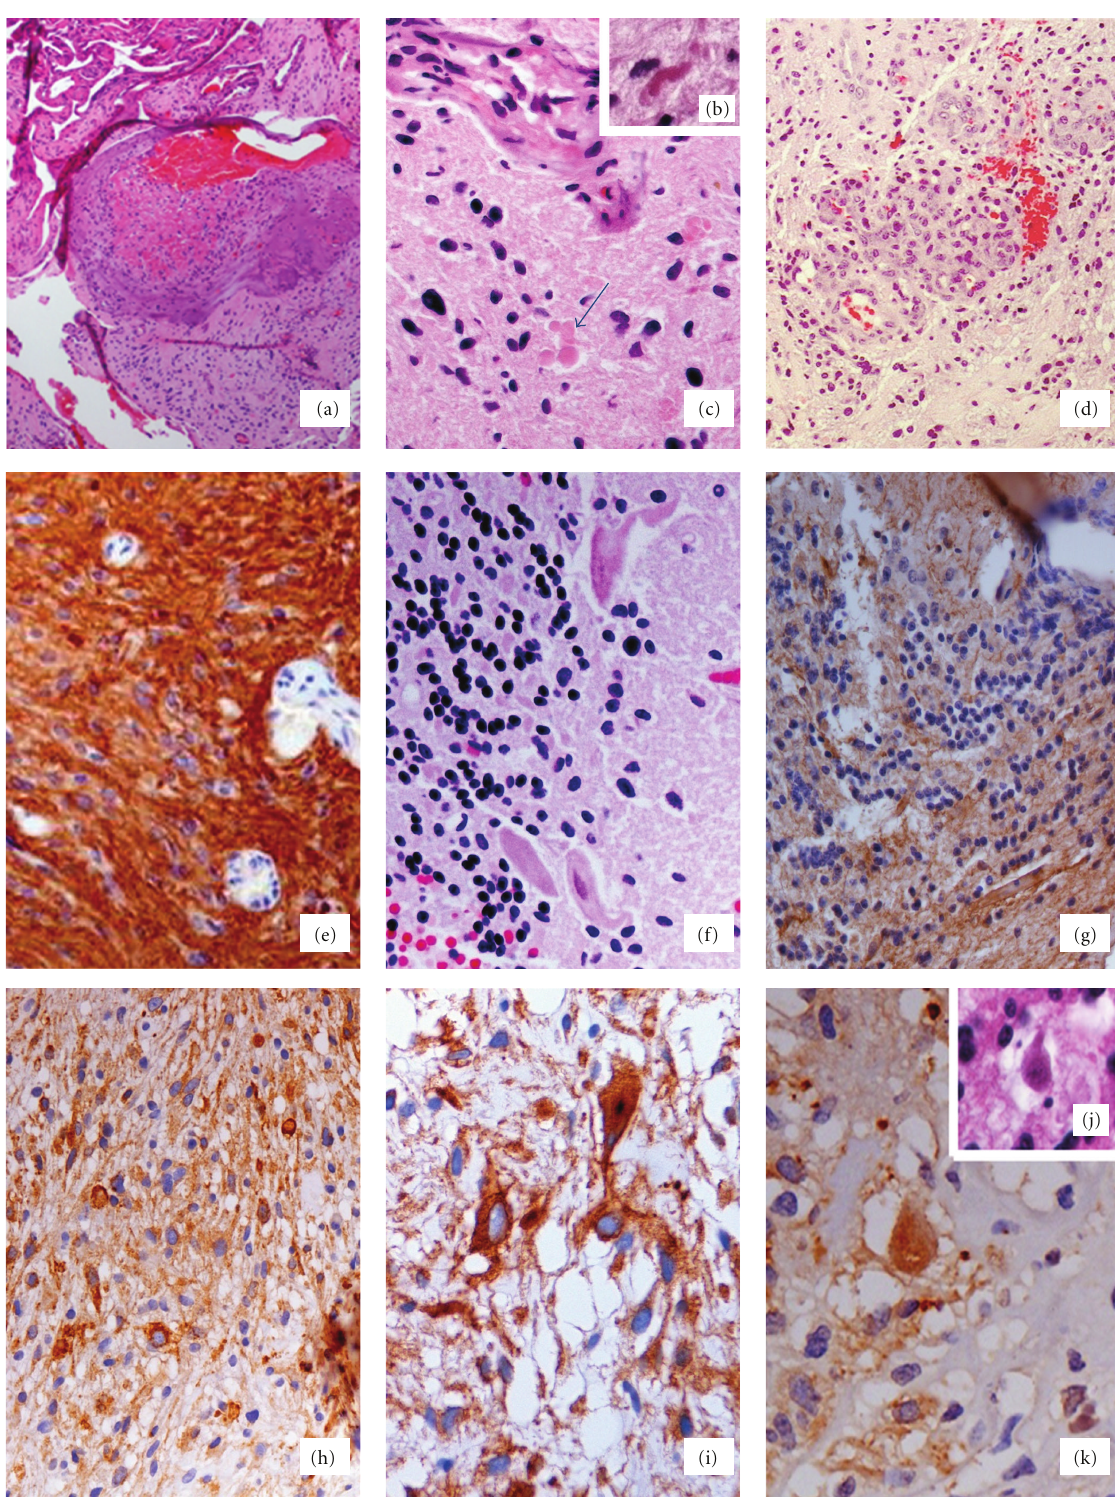
Figure 2: Microscopical findings of the resected tumor. (a) Hamartomatous-hyalinized vessels among the tumor cells can be seen (h and e, × 40). (b) Rosenthal fibers (h and e, × 400). (c) Hyalinized vessels and eosinophilic granular bodies (arrow) (h and e, × 200). (d) Vessels with glomeruloid aspect among tumor cells (h and e, × 100). (e) Strong GFAP expression in the areas with aspect of pilocytic astrocytoma (GFAP, × 200). (f) Area of removed tissue showing normal cerebellar cortex. Some Purkinje cells with abnormal position, and granular cells with normal aspect can be seen (h and e, × 200). (g) Tumor area showing small oligodendroglial-like cells with absence of GFAP positivity (GFAP, × 200). (h) Tumor area with small oligodendroglial-like cells and strong positivity to synaptophysin ( × 100). (i) Cells with larger size and strong synaptophysin expression can be seen. ( × 200). (j) and (k) Floating neurons can occasionally observed within microcysts, h and e (j) and synaptophysin expression (k) ×